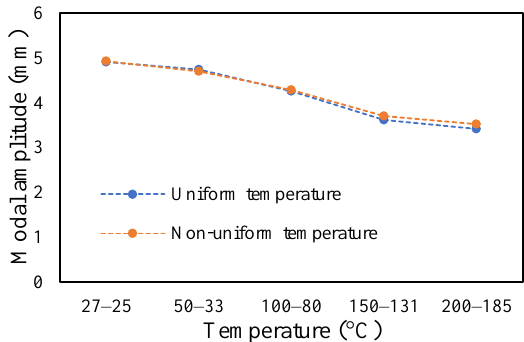
Figure 23. Comparison of modal amplitude of undamaged specimen ramped at 2 °C/min.